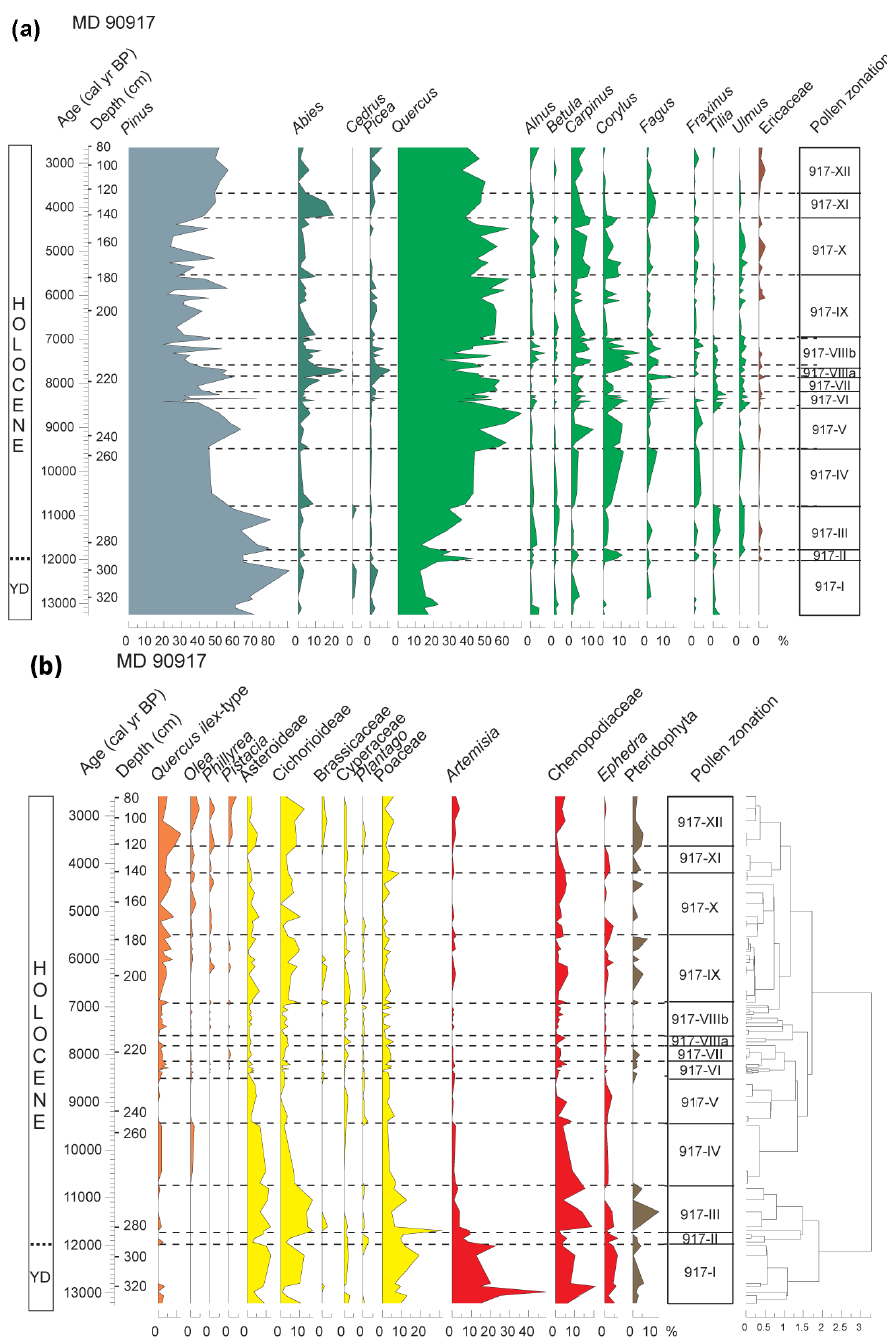
Fig. 2. Pollen diagram of the core MD 90-917. (a) arboreal taxa; (b) Mediterranean and herbaceous taxa. Pollen percentages are calculated on a sum excluding Pinus; Pinus percentages are calculated on the total pollen sum. Pteridophyta percentages are calculated on the total pollen sum. Pollen curves are presented in calendar yr BP (correspondence between age and depth is presented on the left). On the right of the diagram are represented the pollen zones and results of the cluster analysis (CONISS software, Grimm,